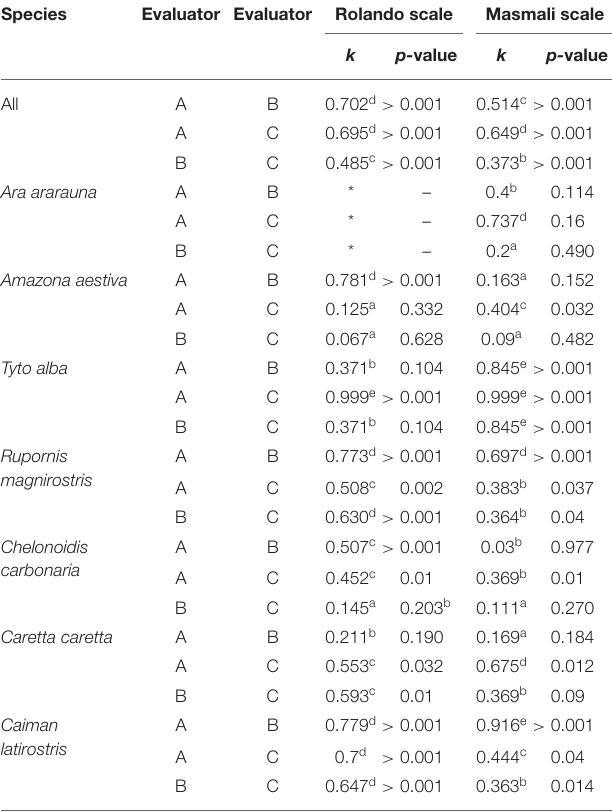
TABLE 4 | Cohen’s kappa agreement coefficient and p -value of the classification between three different examiners (A, B, and C) of birds and reptiles tear crystallization, according to the Rolando and Masmali